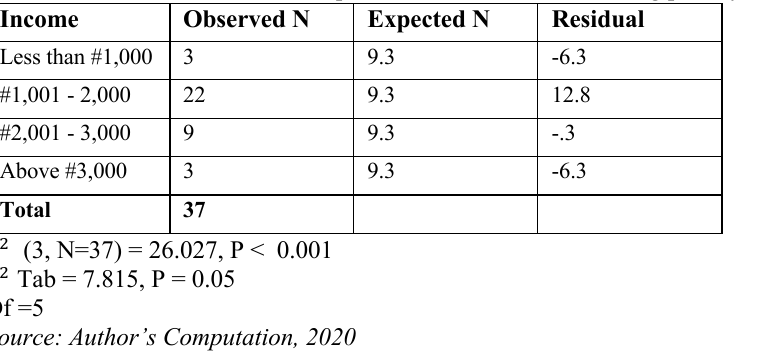
Table 4. Statistical Estimate of Respondents’ income from hawking per